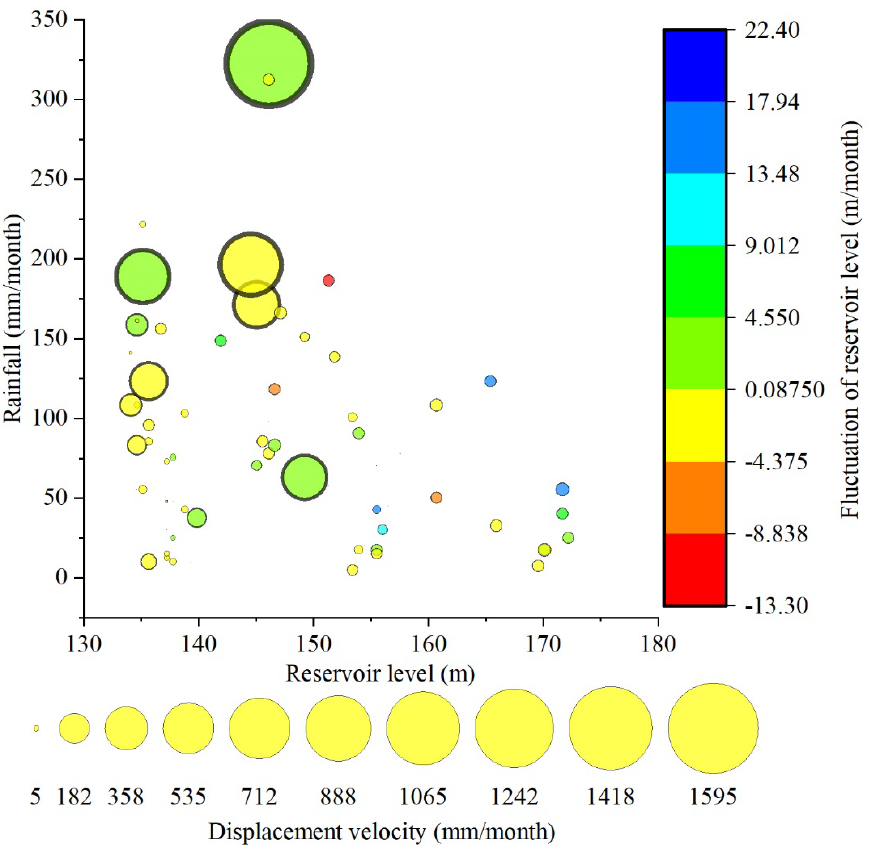
Figure 8. Correlation of displacement velocity at G1 versus the reservoir level, rainfall, and fluctuation of reservoir level.